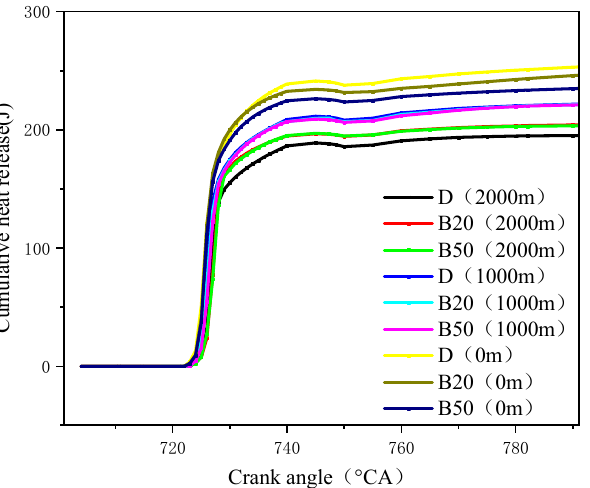
Figure 6. Effect of different plateau environments on cumulative heat release of diesel with different blending ratios.